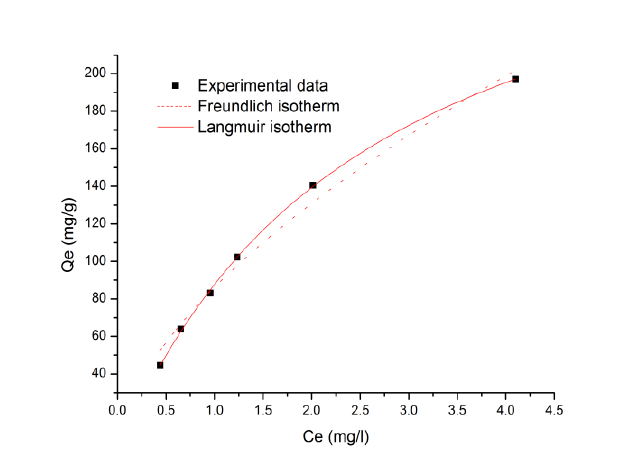
Figure 5. Adsorption isotherms - non-linear regression of copper adsorption on Brushite